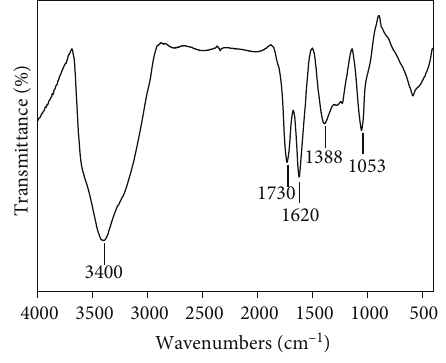
Figure 5: FTIR spectra of